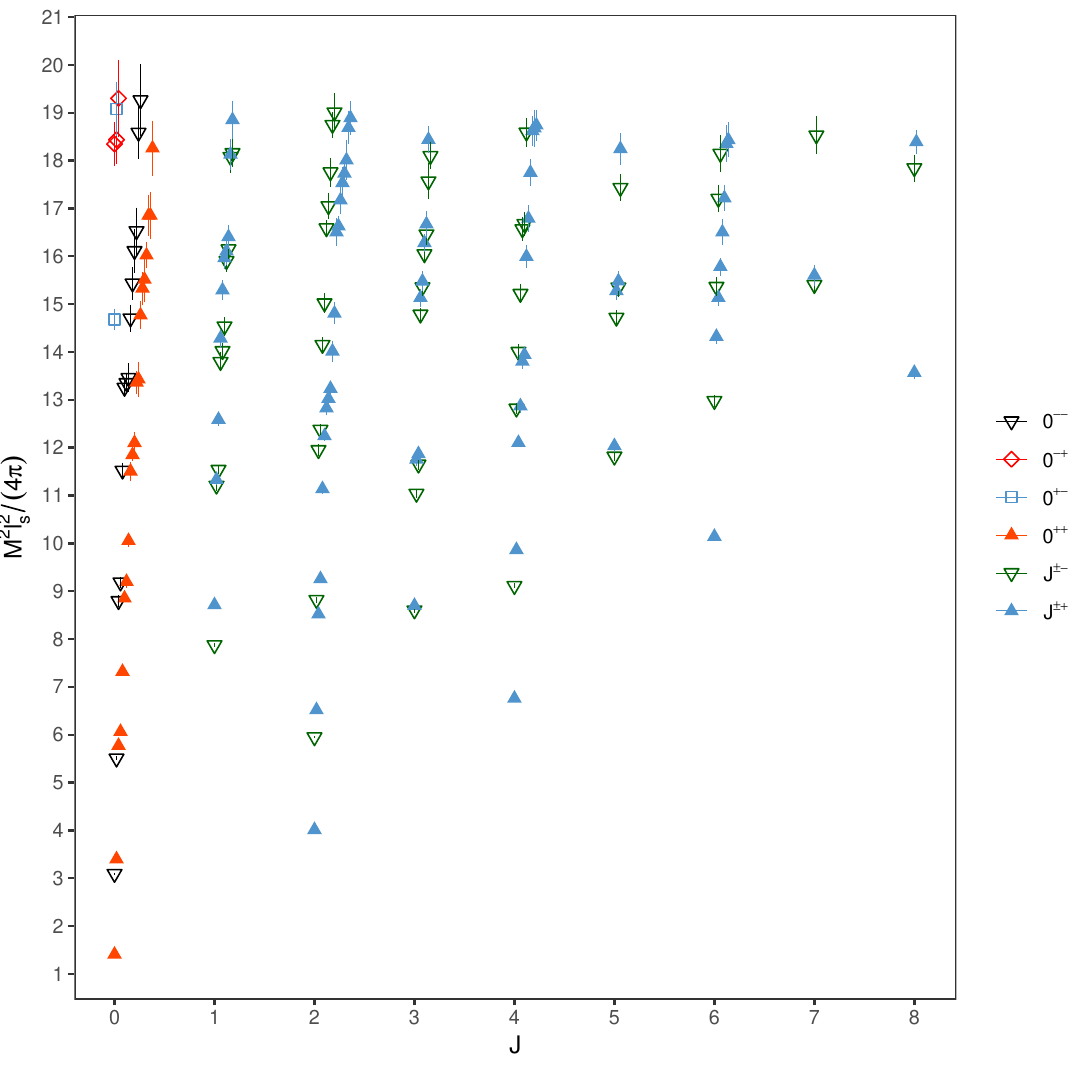
Figure 5. The Chew-Frautschi plot.